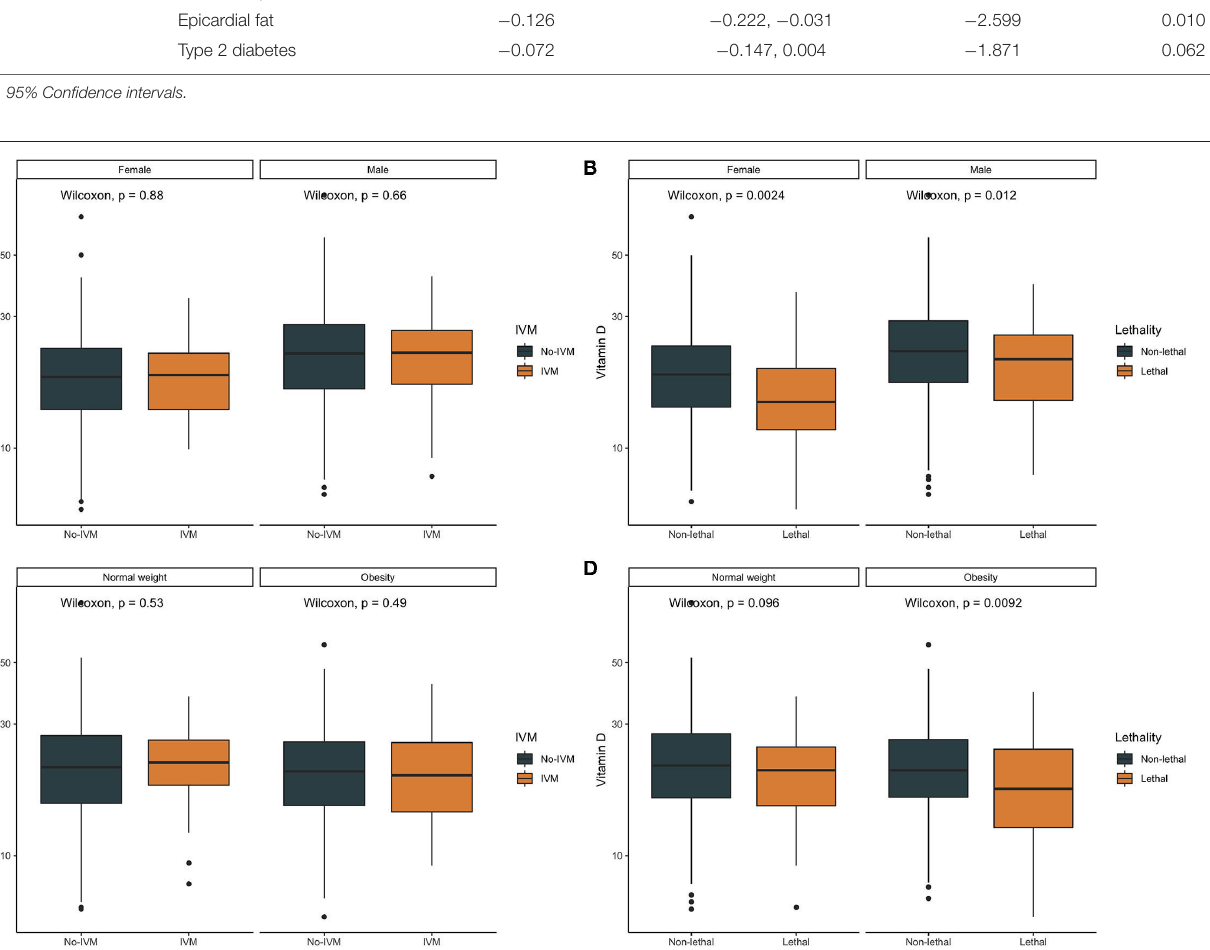
levels of proinflammatory angiotensin II. Hence, vitamin